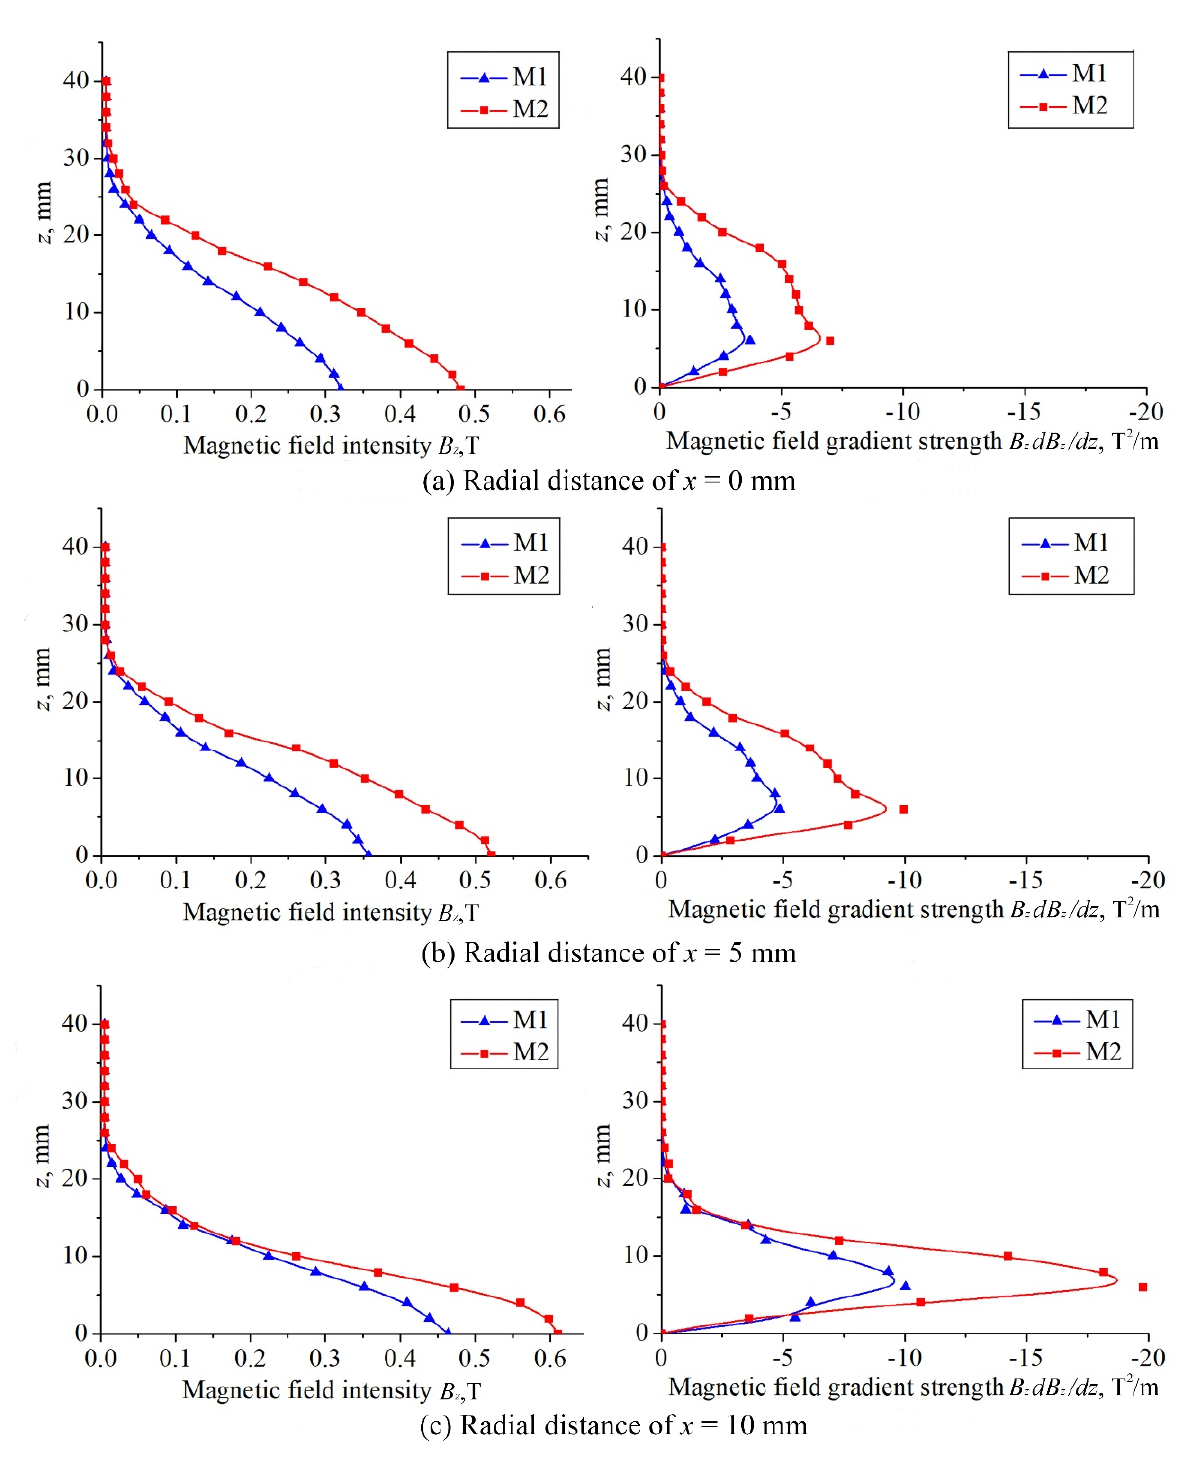
Figure 2. Vertical distributions of magnetic field intensity and gradient along three lines in Figure 1 at ( a ) x = 0 mm, ( b ) x = 5 mm, and ( c ) x = 10 mm, respectively.